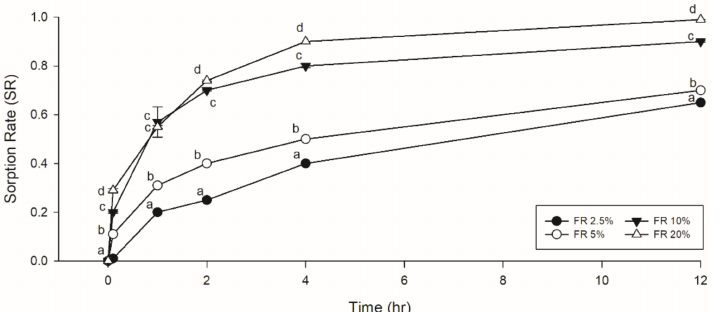
Figure 1. Sorption of ethyl formate according to filling ratio (FR) and fumigation time, expressed as the sorption rate (SR; mean ± SE), which is the ratio of the headspace content of EF at a specified time of fumigation ( C 0 – C n ) to the initial applied concentration ( C 0 ). Means at each timepoint followed by the same letters are not significantly different (Tukey’s HSD test; p =